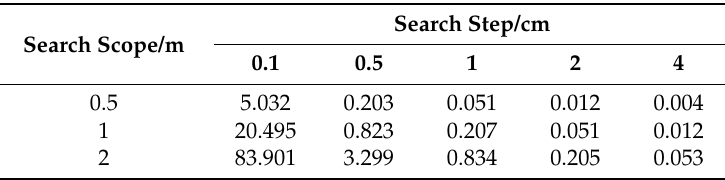
Table 1. Search time under different